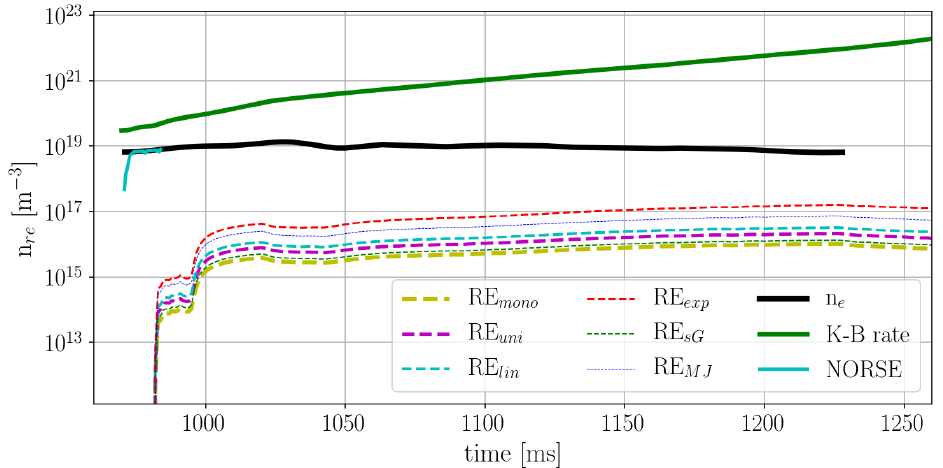
Figure 3. Time traces of total electron density (black) measured with interferometer, RE density from Kruskal–Bernstein theory (green), RE density from NORSE simulation (cyan) and RE densities corresponding to RE currents from Figure 2c (dashed